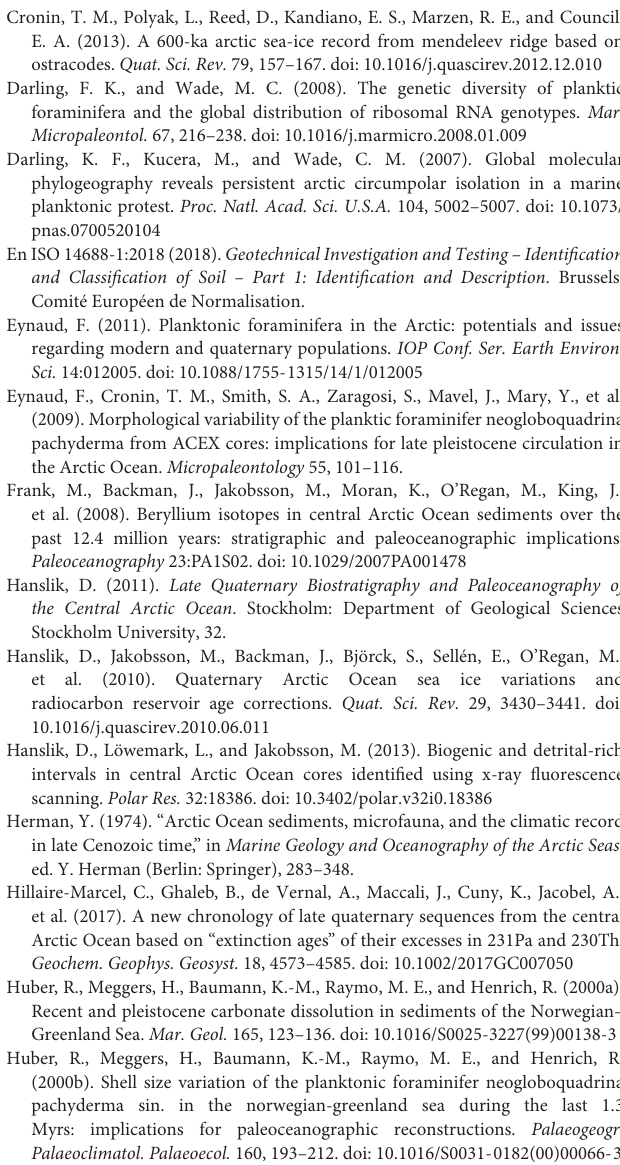
FIGURE S1 | Stratigraphic correlation of multiple records across ∼ 575 km of the Lomonosov Ridge. Here the K/Ti ratio from XRF-scanning data is illustrated using the correlations presented in Figure 5 of the manuscript. The bold red correlative line indicates the position of a distinct fine-grained (95–100% clay) peach colored layer (labeled PL). Greek symbols ( α , β , γ ) highlight a correlative sequence of grain size and color variations that are recognised above the fine-grained peach colored layer (PL). The two diamicts found near the top of all the cores are labeled D B and D A . FIGURE S2 | Stratigraphic correlation of multiple records across ∼ 575 km of the Lomonosov Ridge. Here the Mn/Ti ratio from XRF-scanning data is illustrated using the correlations presented in Figure 5 of the manuscript. The bold red correlative line indicates the position of a distinct fine-grained (95–100% clay) peach colored layer (labeled PL). Greek symbols ( α , β , γ ) highlight a correlative sequence of grain size and color variations that are recognised above the fine-grained peach colored layer (PL). The two diamicts found near the top of all the cores are labeled D B and D A